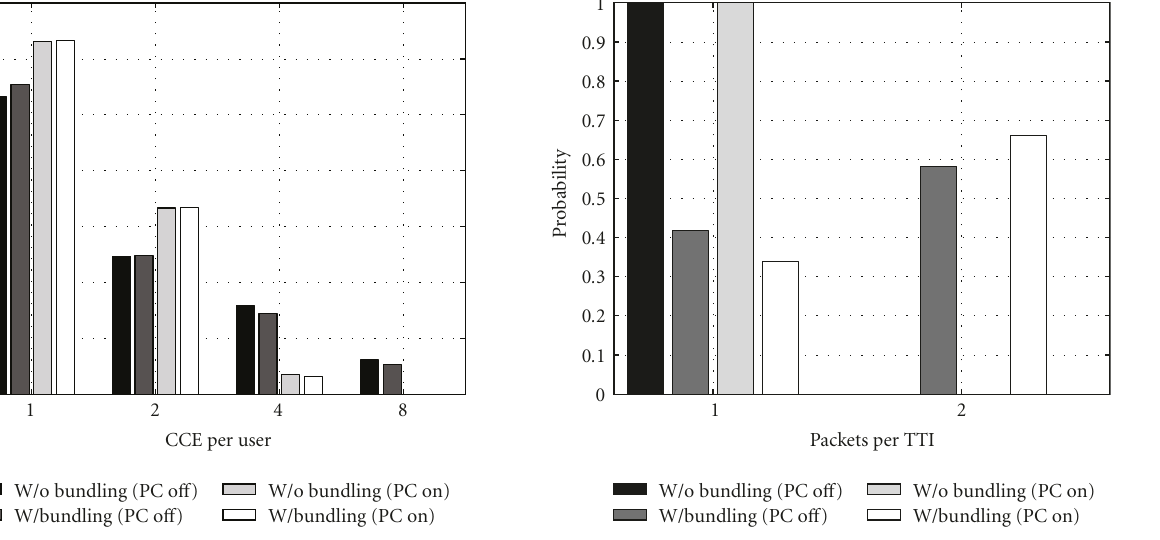
Figure 6: Distribution of CCE aggregation level (Macro Case 3).